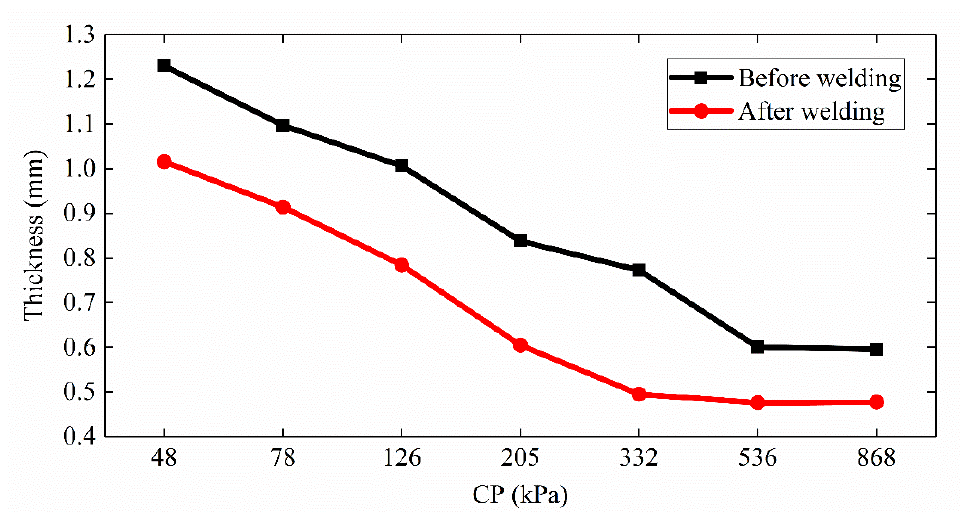
Figure 8. Thickness of double intestinal tissue before and after welding under seven levels of compression pressure (CP). When the CP is lower than 205 kPa, the tissue thickness after welding is smaller than the initial spacing between electrodes, increasing the contact impedance between the electrodes and the small intestine. Changes in tissue thickness have less effect on contact impedance above 332 kPa.